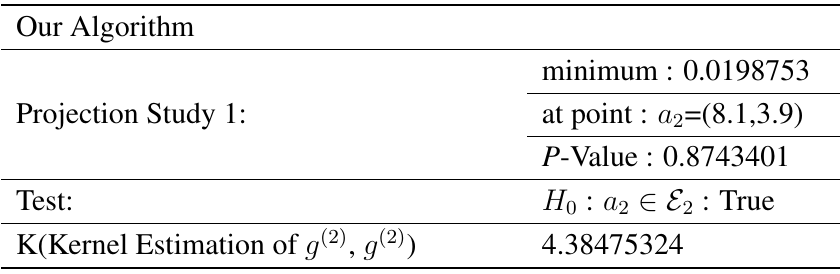
Table 6. Numerical results: Second